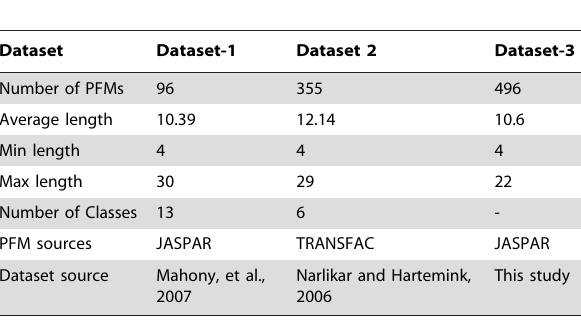
Table 1. Three datasets used in this study for testing and